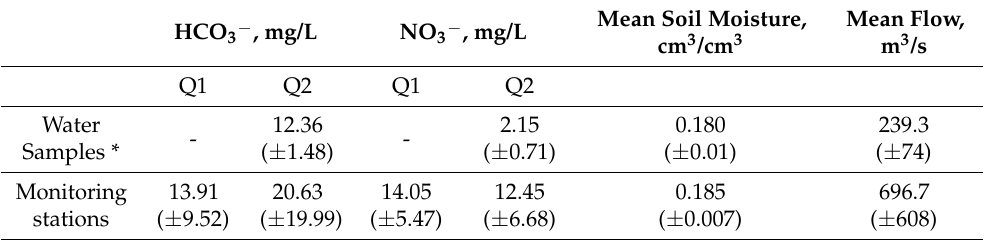
Table 4. Mean concentrations of HCO 3 − and NO 3 − from water samples and continuous monitoring.